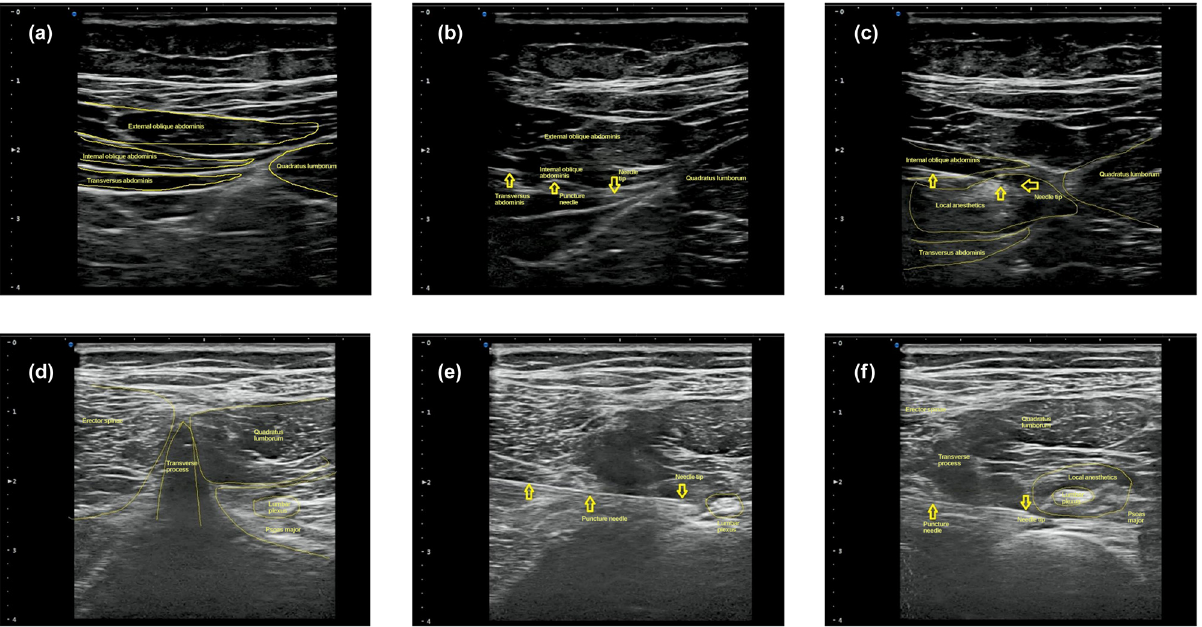
Figure 1: Ultrasound images during local anesthesia. ( a – c ) Transversus abdominis plane block group ( group T ) . ( d – f ) Lumbar plexus block group ( group L ) . a/d, b/e, and c/f are representative images for positioning, puncture, and 3 min after drug injection, respectively. The yellow arrows show the position of puncture